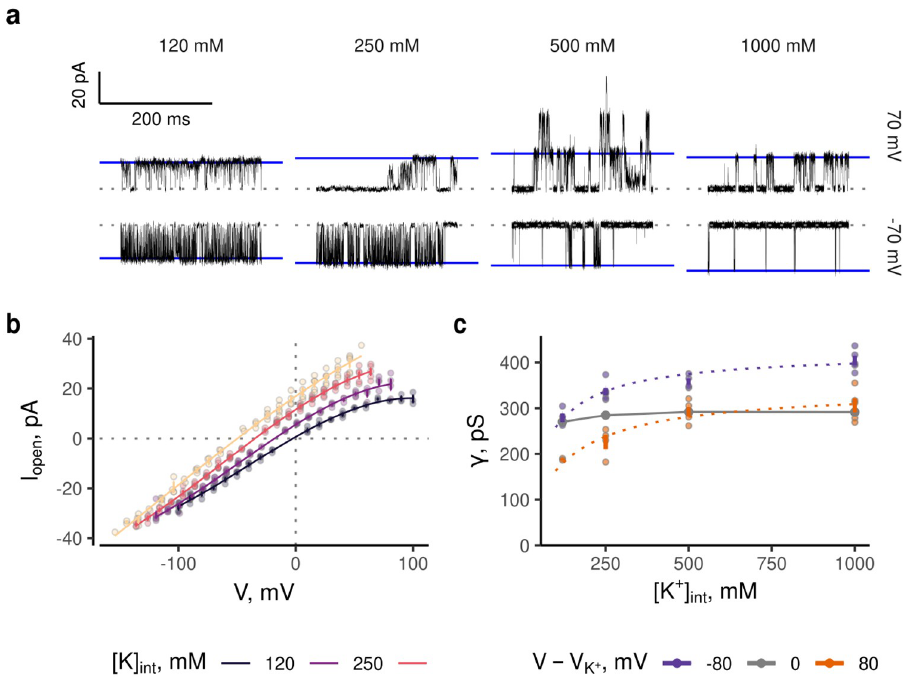
Fig 3. Single-channel behavior in high internal ionic strength. a ) Example time-courses of low P currents in solutions of varying K + concentration and ionic strength. Outward (top row) and inward (bottom row) single channel currents at a net driving force of ± 70 mV. Different subconductances and channel flickers are apparent. Fitted amplitudes for the closed (grey) and open state (blue) are shown as horizontal lines, passive leak current was subtracted. b ) Amplitudes were extracted from short stretches of recordings 0.95 s at voltages ranging from 100 mV either side of the calculated reversal potential in the given K + gradient. Data collected at high ionic strength (500 mM) represent opening events recorded from residual activity of patches conducting macroscopic currents in the baseline condition (large amount of channels). Lines represent a third order polynomial fit. Number of patches for each reconstructed curve is at least 4 whereas the number of replicates at a given voltage can be less, if the amplitude could not be determined due to lack of openings. c ) Estimates of γ plotted against the internal potassium concentration. Amplitudes were divided by the driving force for K + . The slope at the point of current reversal (y-axis intercept of the fit in panel a) was taken for the 0 mV value.